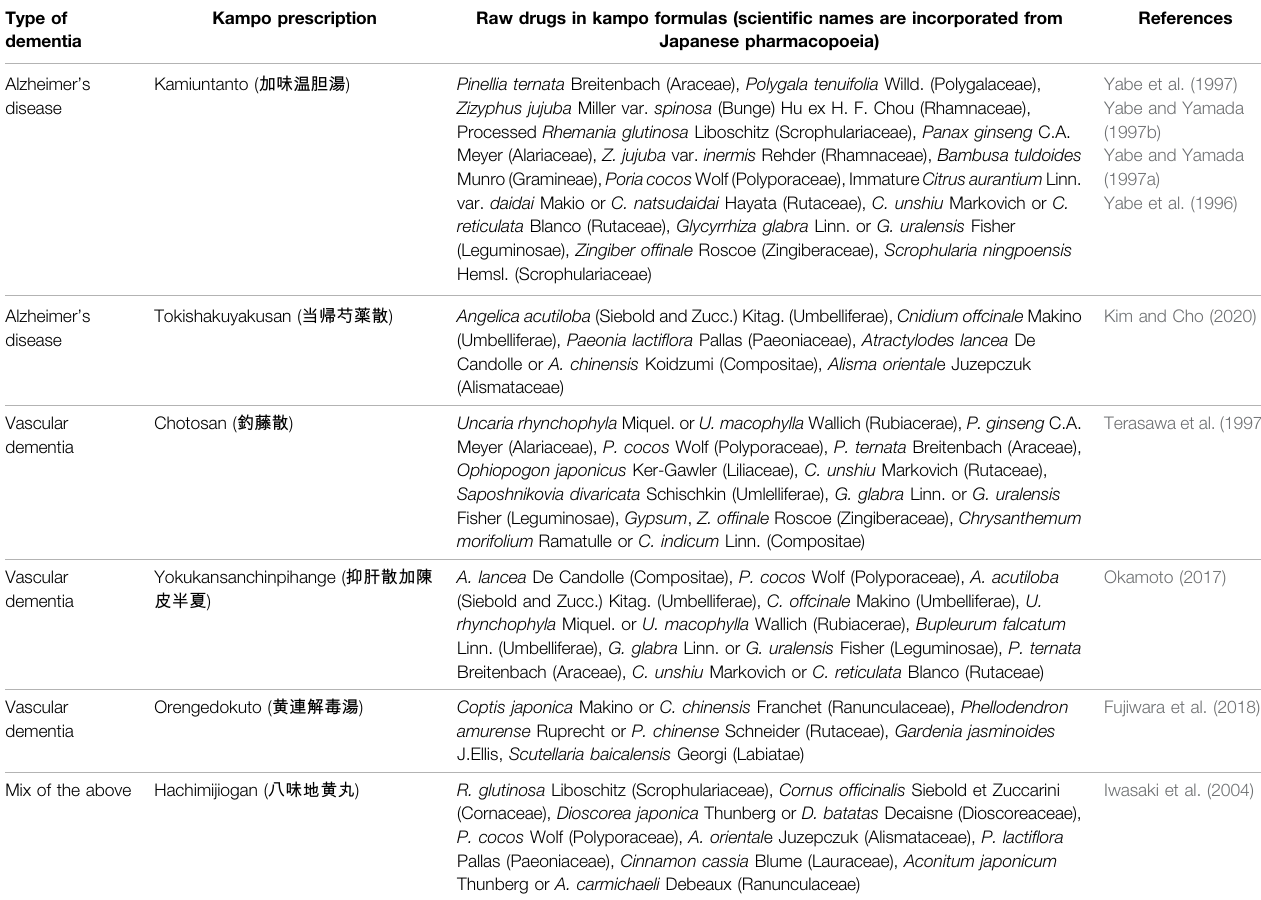
TABLE 1 | Clinically used anti-dementia Kampo formulae in